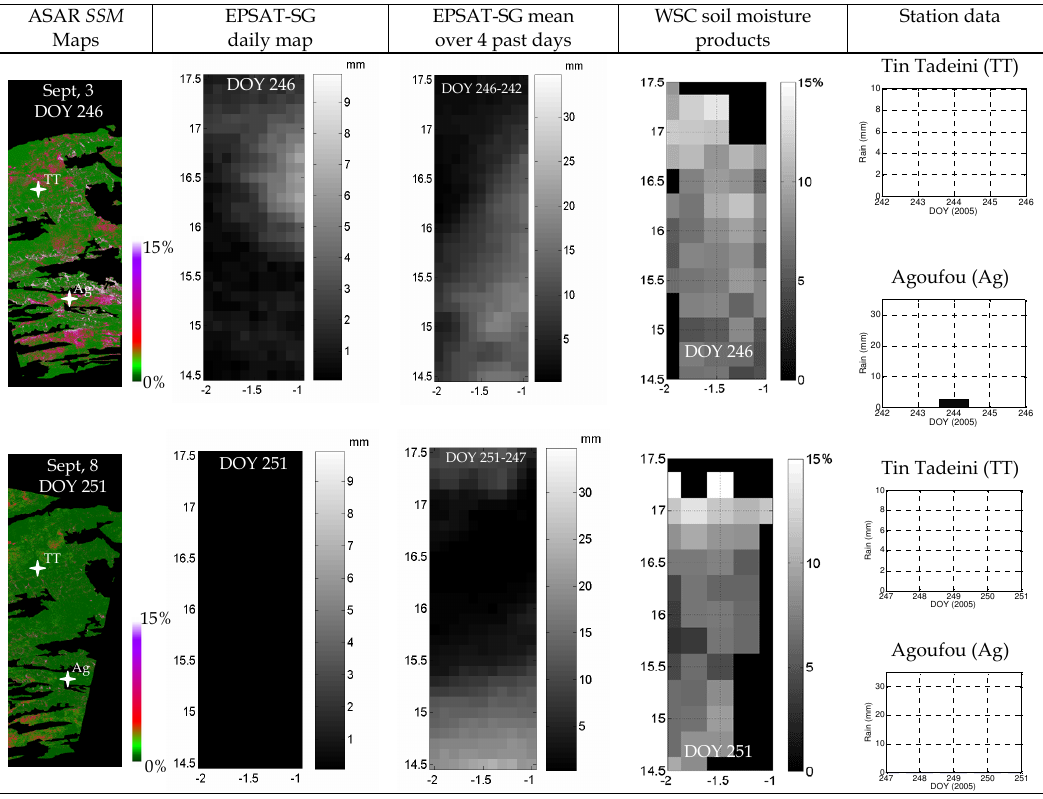
Fig. 10. Comparisons of September soil moisture (SSM) maps (3 rd and 8 th ) derived from ENVISAT-ASAR and ERS WSC soil moisture products and EPSAT-SG rainfalls estimates on the same day and over the four previous days, and with rainfall recorded at Agoufou and Tin Tadeini during the five same